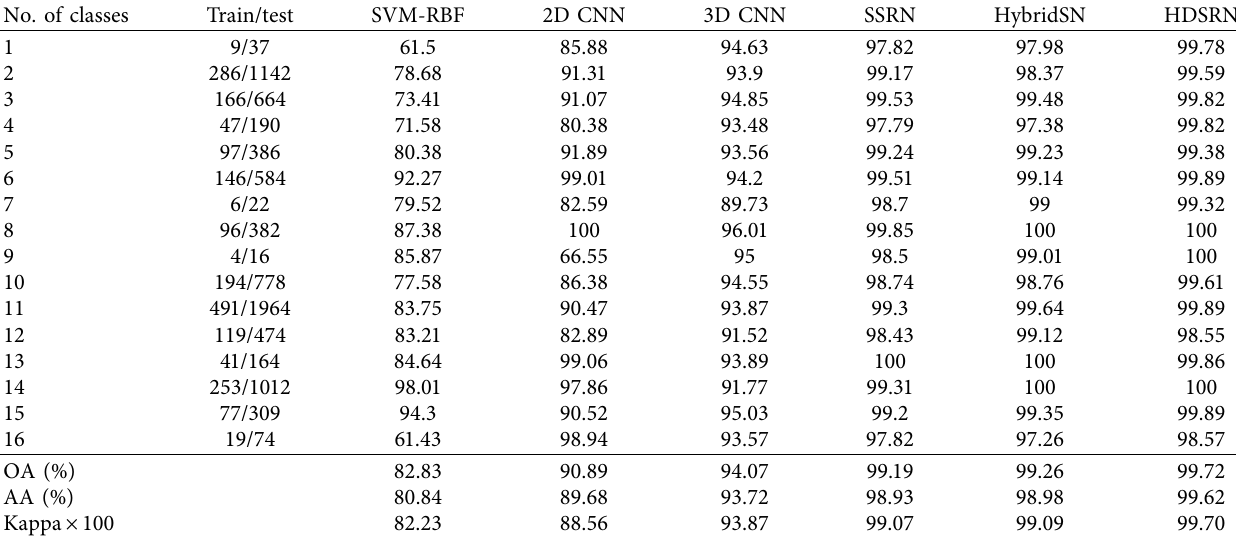
Table 8: The comparison experiments in the IN dataset.